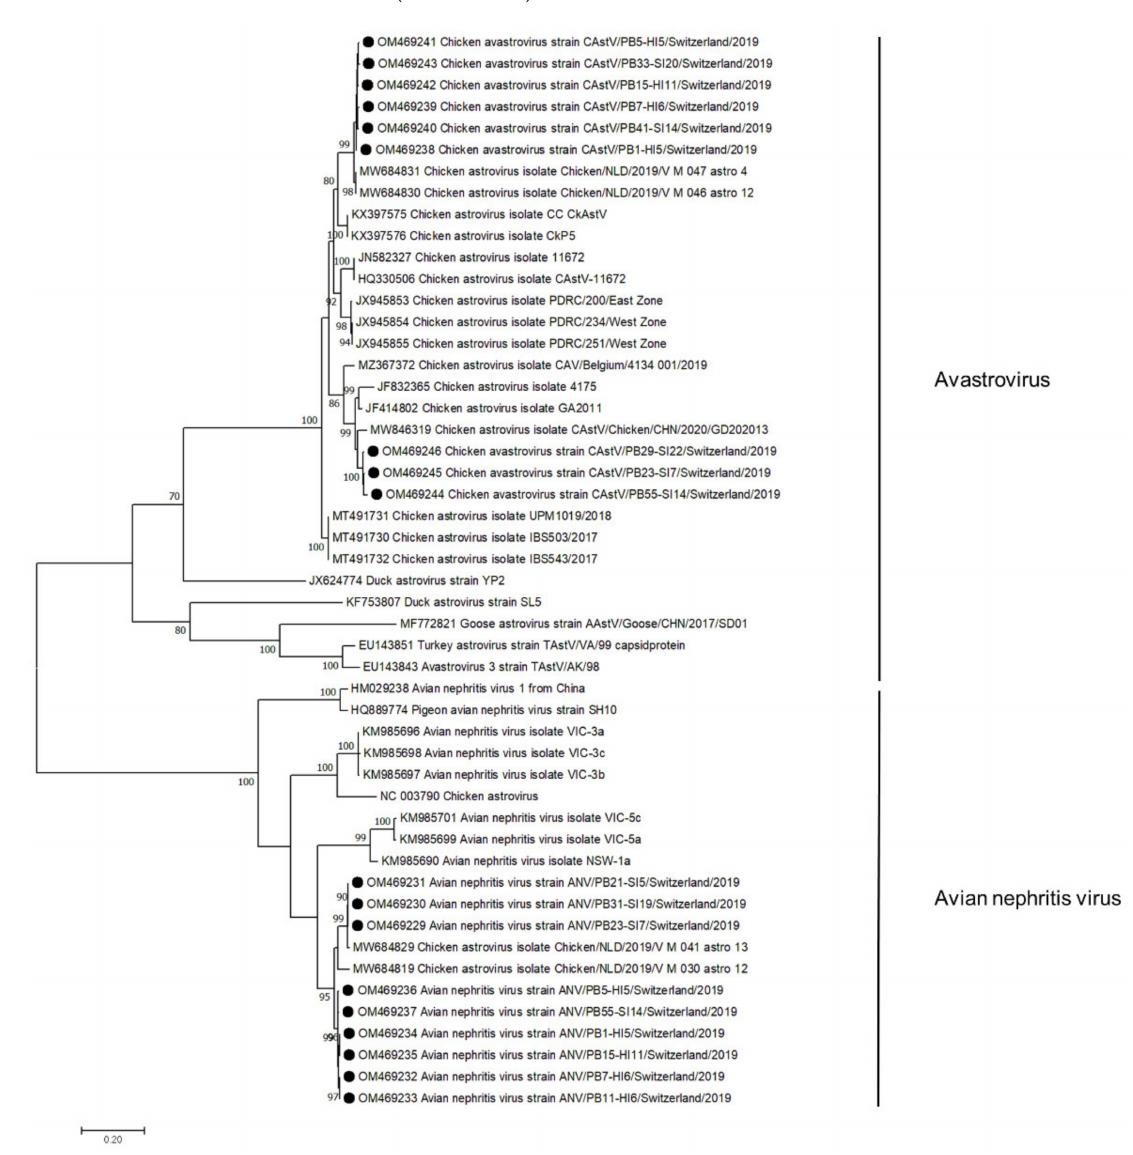
Figure 3. Phylogenetic tree based on the amino acid sequence identity of the capsid protein of avian avastroviruses and avian nephritis viruses. Genomes identified in this study are marked with black dots. Phylogenetic analysis was performed using the maximum likelihood algorithm based on the Tamura–Nei model with the 1000 replication bootstrap method. Only values ≥ 70% were displayed. Evolutionary analyses were conducted using MEGA